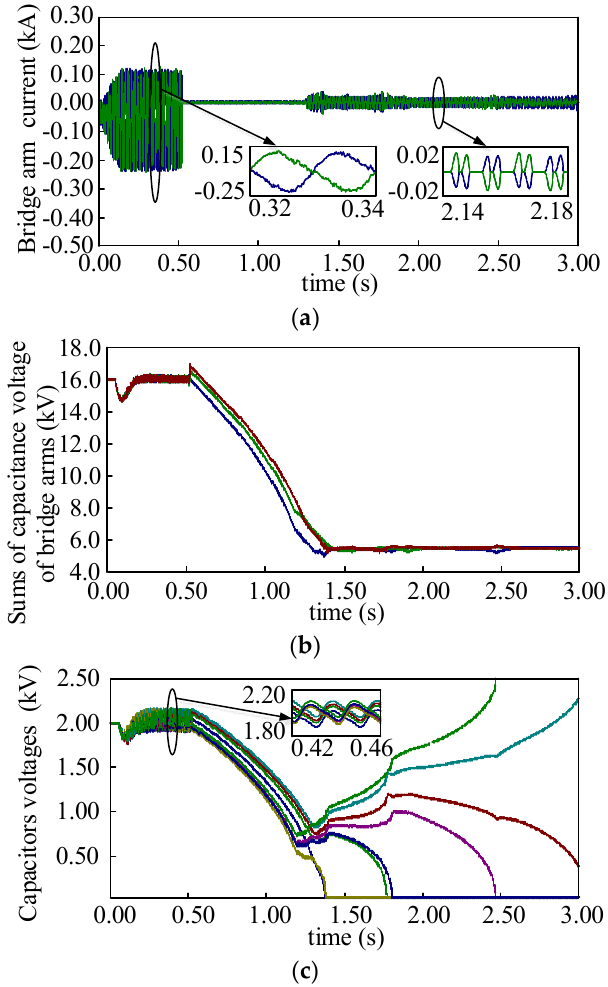
Figure 4. The waveform of capacitor voltage divergence after the converter is blocked. ( a ) Bridge arm current; ( b ) sum of capacitor voltages of bridge arm, and ( c ) capacitor